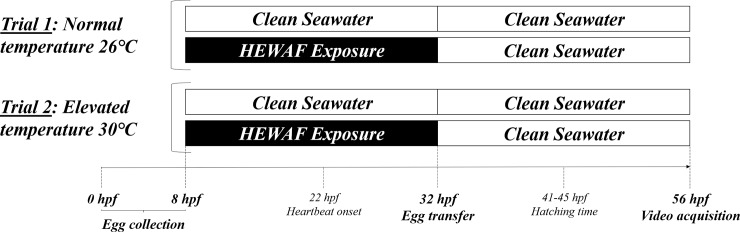
Experimental design.Mahi embryos (eight hpf) were exposed to HEWAF solutions during 24 hours and subsequently transferred to clean seawater for an additional 24 hours of development. Exposures were performed at two temperatures: a “normal” temperature of 26°C and an “elevated” temperature 30°C. Each temperature trial included a control group raised in seawater only. hpf; hours post-fertilization.